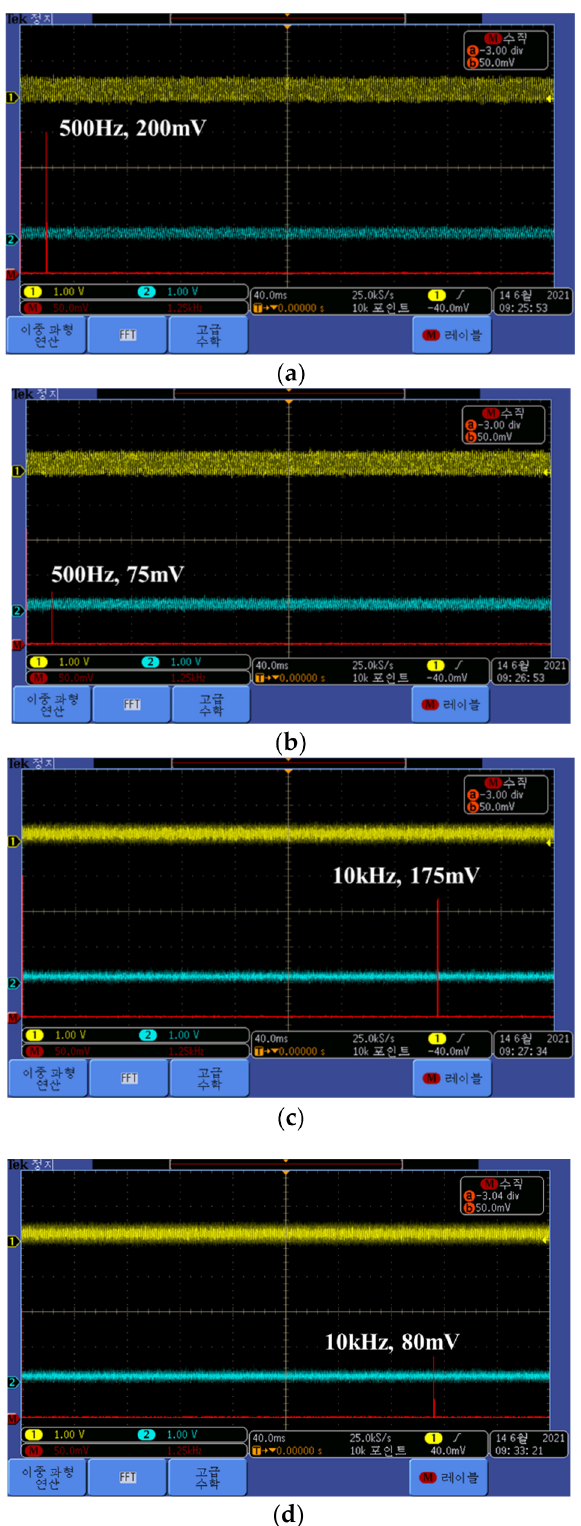
Figure 33. Receiver response characteristics regarding disturbance: ( a ) 500 Hz input; ( b ) 500 Hz output; ( c ) 10 kHz input; ( d ) 10 kHz output. Table 4. Comparison of the response characteristics to disturbance.